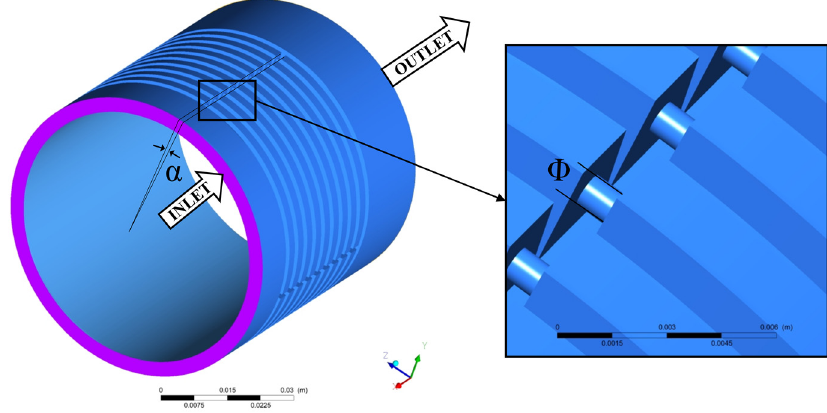
Figure 2. Schematic diagram of the hole diaphragm labyrinth seal (HDLS).